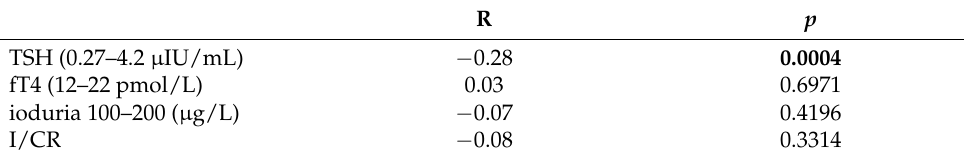
Table 2. Correlations between the thyroid volume and the thyroid function.